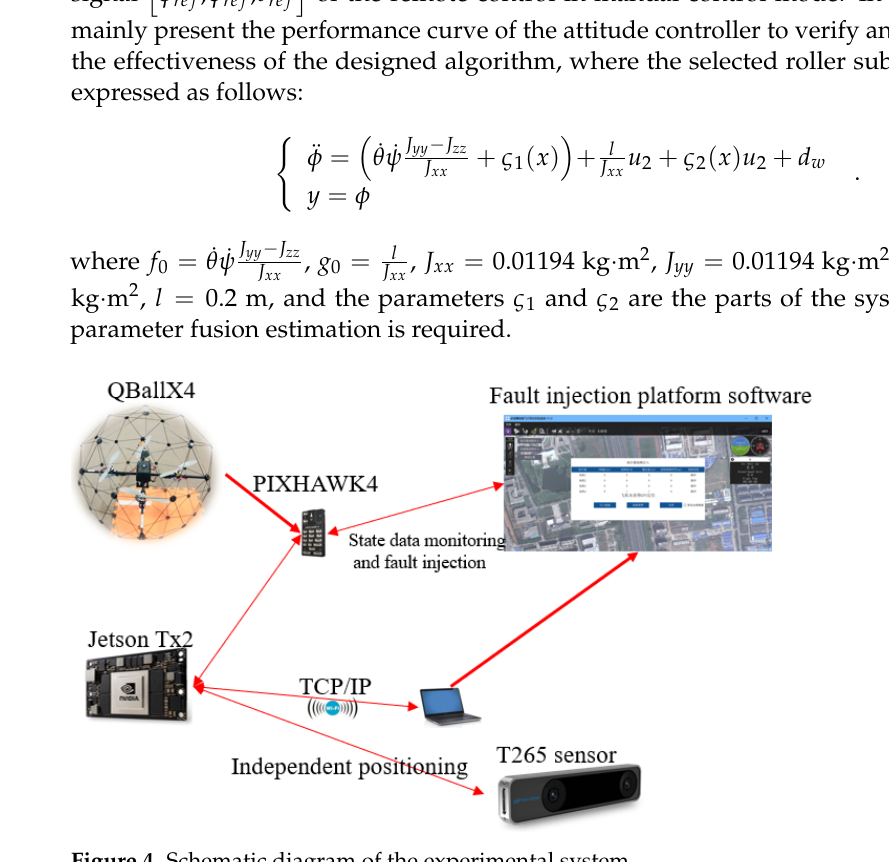
Figure 4. Schematic diagram of the experimental system.